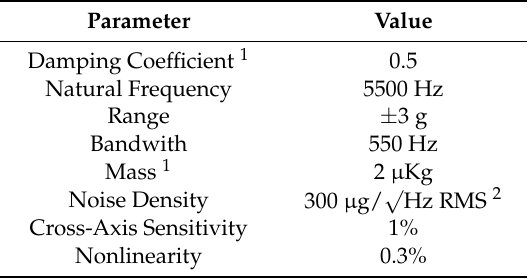
Table 1. Considered parameters of accelerometer